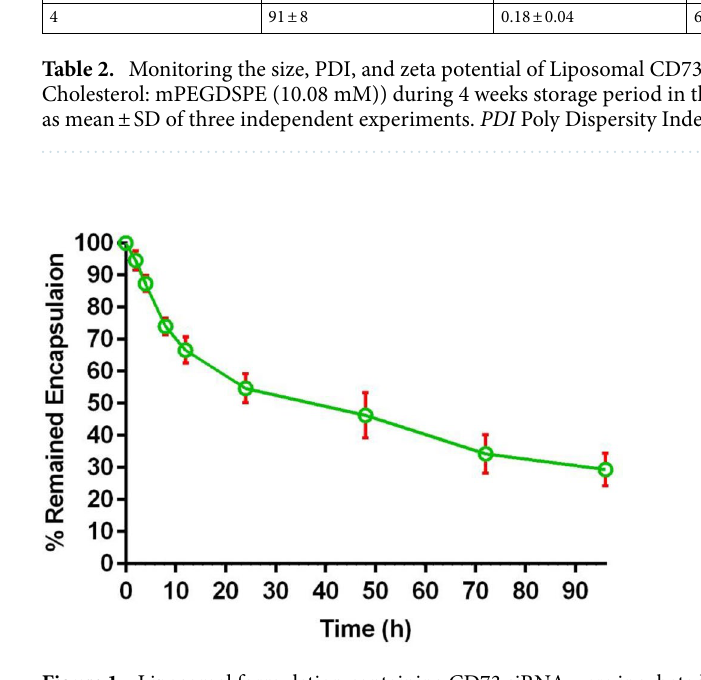
Figure 1. Liposomal formulation containing CD73 siRNA were incubated in the PBS/FBS medium at 37 °C for 96 h. The amount of remained siRNA reached near to 50% after 24 h incubation in the PBS/FBS medium at 37 °C and it decreased to around 30% after 96 h incubation. Data are shown as mean ± standard deviation (n =